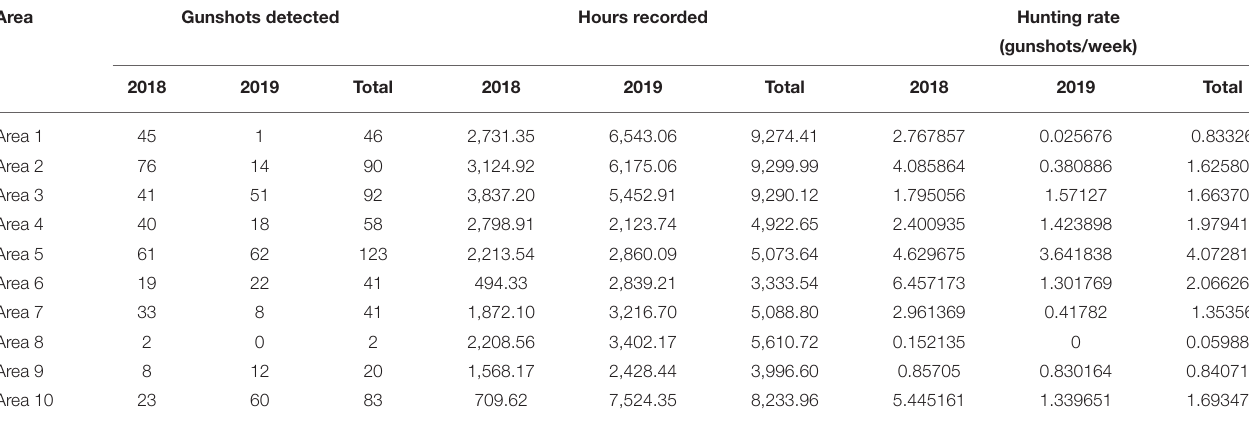
TABLE 1 | Total number of shots identified, total number of recorded hours and hunting rate (shots/week) for year of the study and overall. Area Gunshots detected Hours recorded Hunting rate